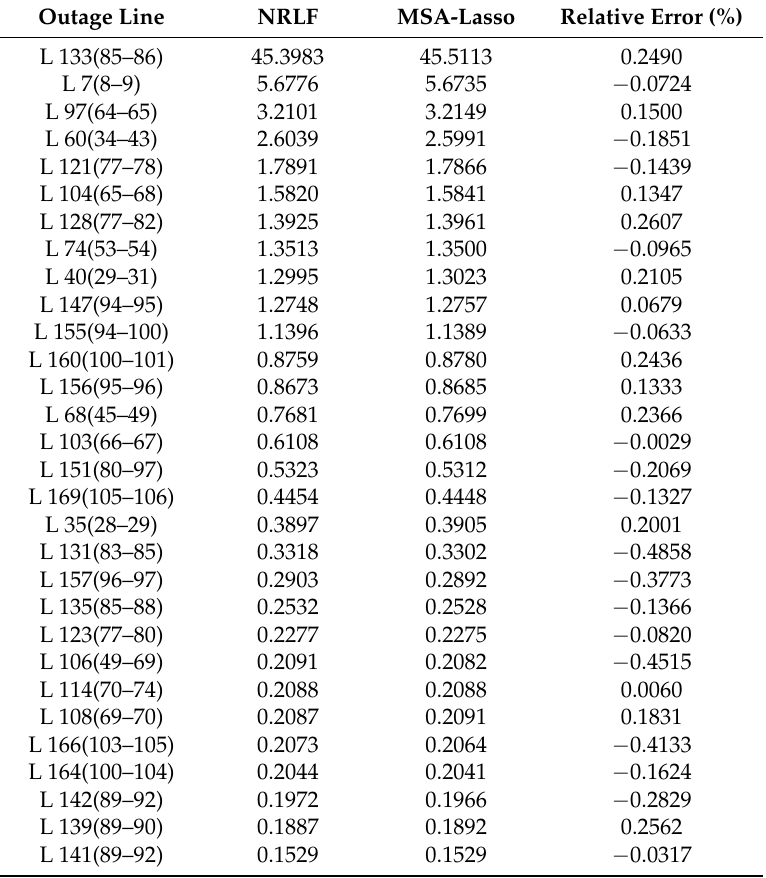
Table 12. Security index results of two methods in the base load condition of the IEEE 118-bus system.